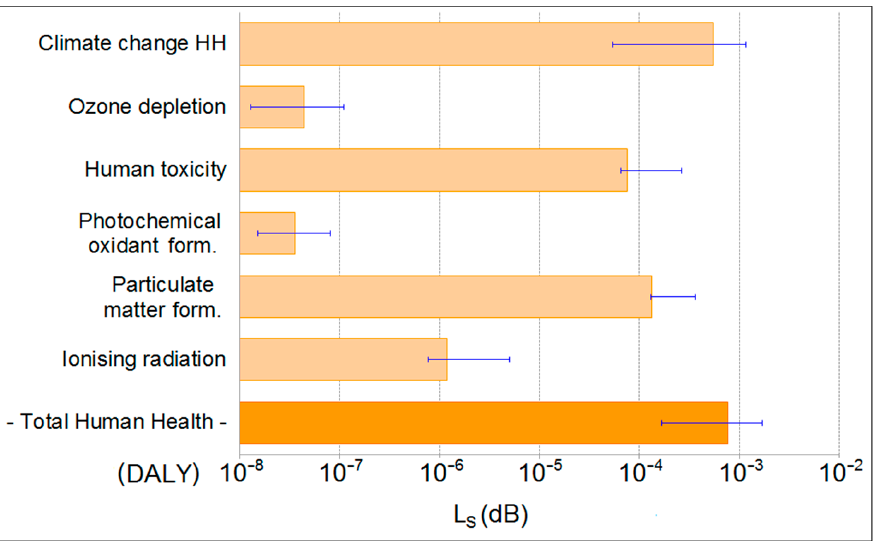
Figure 7. Confidence intervals for total human health indicator in relation to its components.